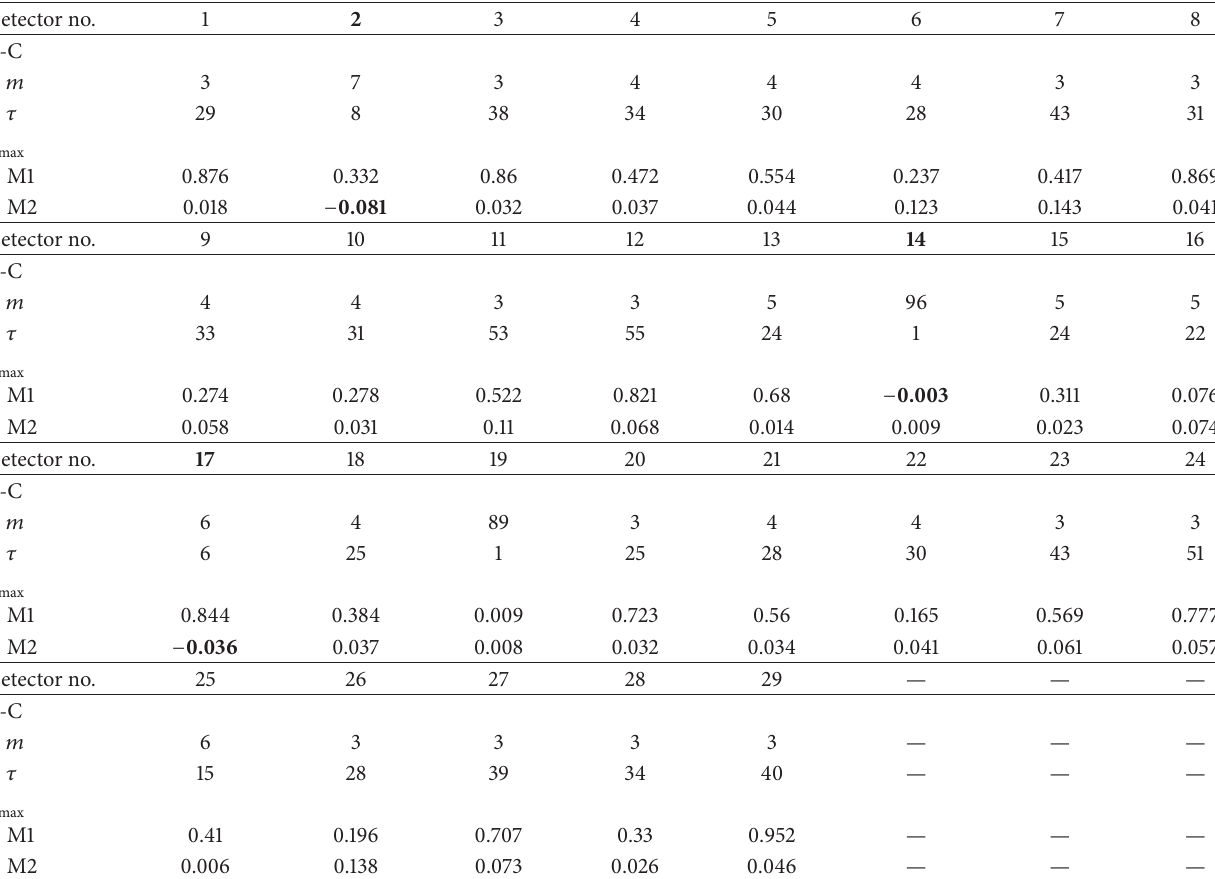
Table 4: C-C method result and Lyapunov exponents for